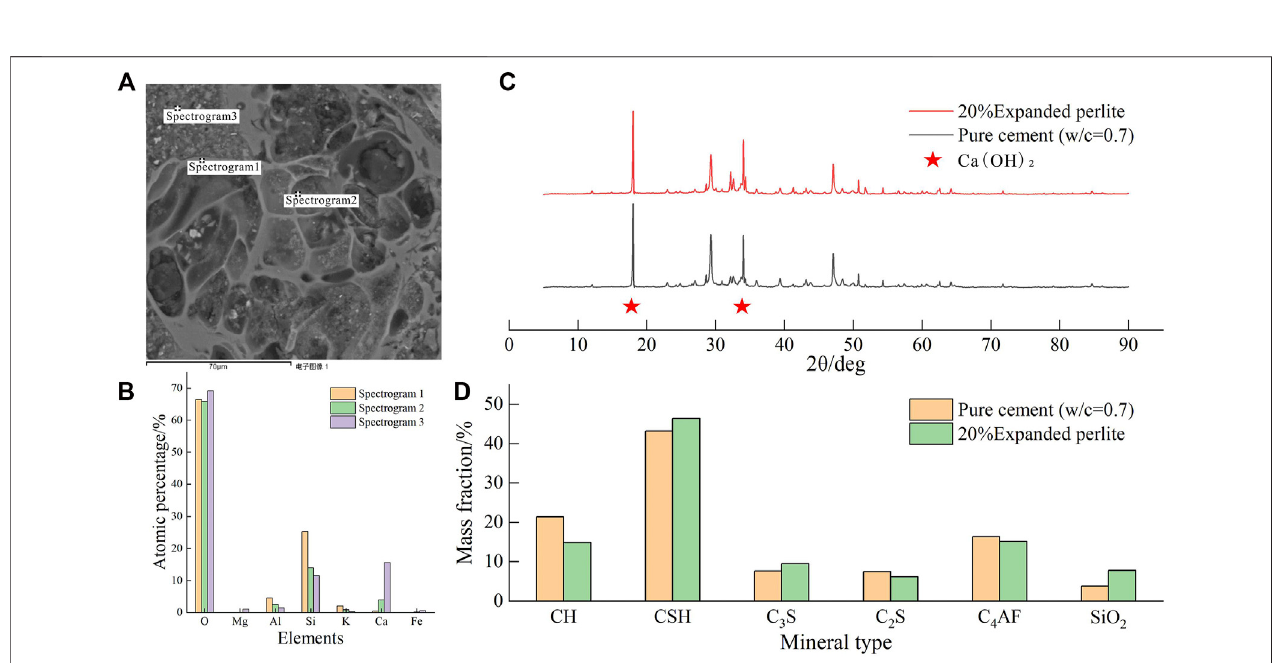
FIGURE 8 | Microstructure and related parameters of thermal insulation cement with expanded perlite. (A) Microstructure of thermal insulation cement with 10% expanded perlite under the microscope. (B) Microstructure of thermal insulation cement with 20% expanded perlite under the microscope. (C,D) Microstructure of expandedperliteunderSEM. (E) Microstructureofthermalinsulationcementwith10%expandedperliteunderSEM. (F) Microstructureofthermalinsulationcementwith 20% expanded perlite under SEM. (G) Dry density and median pore throat radius of thermal insulation cement with expanded perlite.